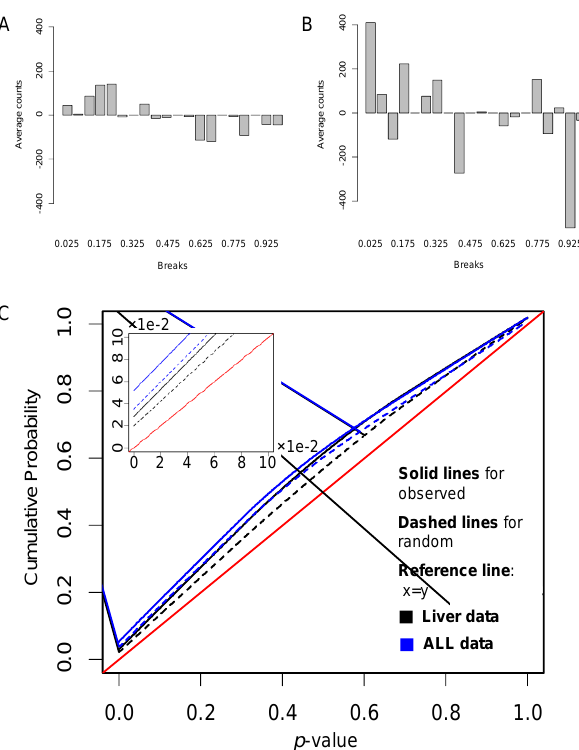
Figure 4. Differences between the p -value distributions of true gene links and random links on liver data and ALL data. ( A , B ) The differences between counts of p -values resulted by the true gene links and the randomly generated links in each bin for ( A ) liver data, ( B ) ALL data, and ( C ) the cumulative probability distributions of p -values of true links and random links on liver data and ALL data.